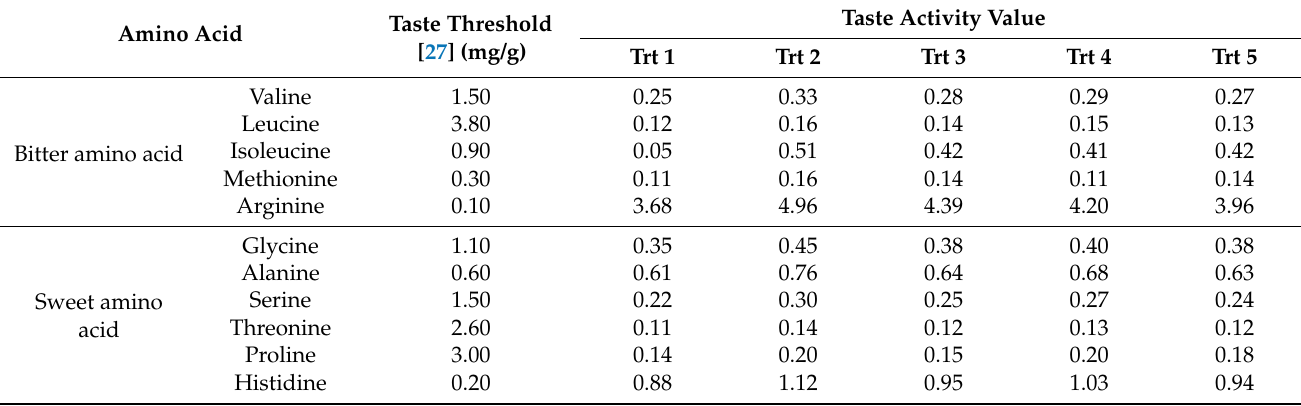
Table 5. Taste activity values of flavoring amino acids in the pericarp of Z. planispinum in different planting